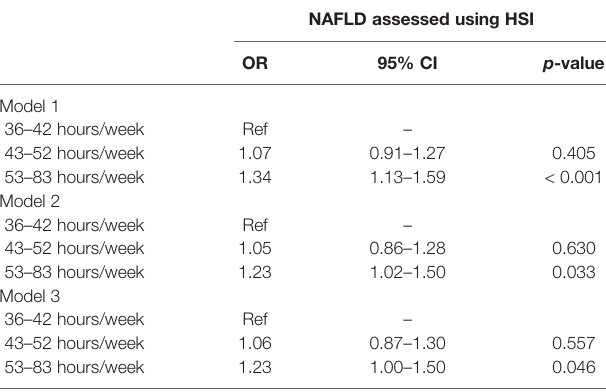
TABLE 2 | Association between working hours and